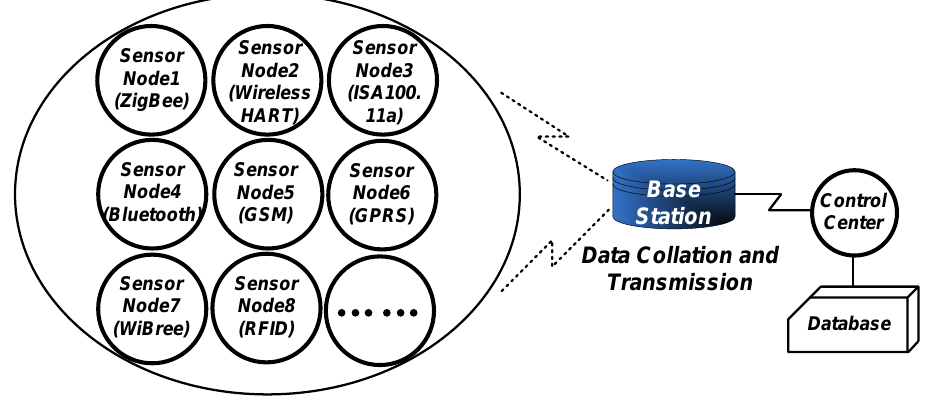
Figure 1. A typical wireless sensor network (WSN) topology. Figure 1 . A typical wireless sensor network (WSN) topology.